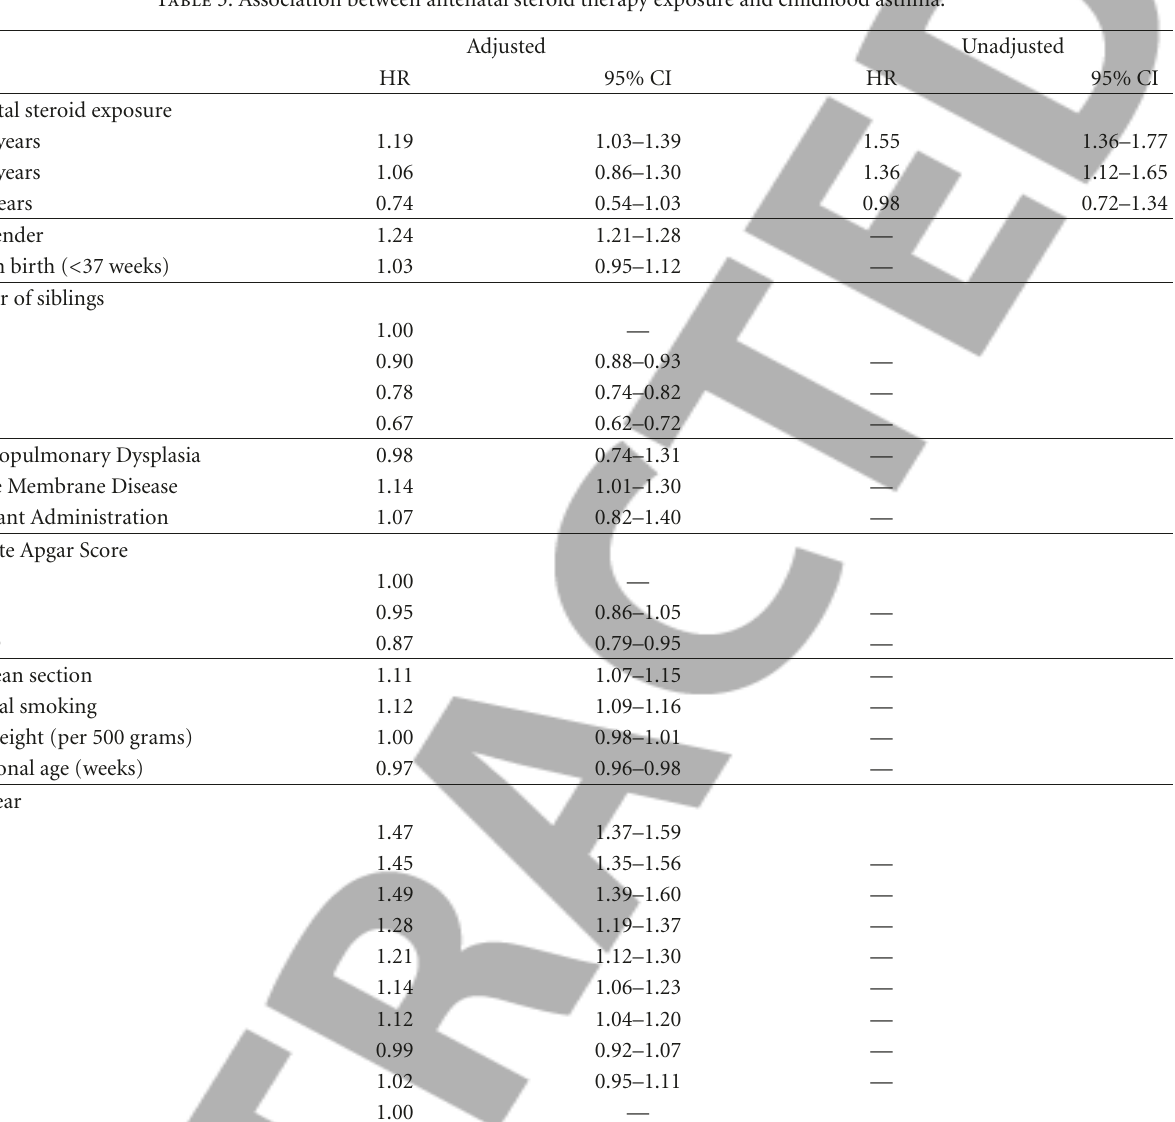
Table 3: Association between antenatal steroid therapy exposure and childhood